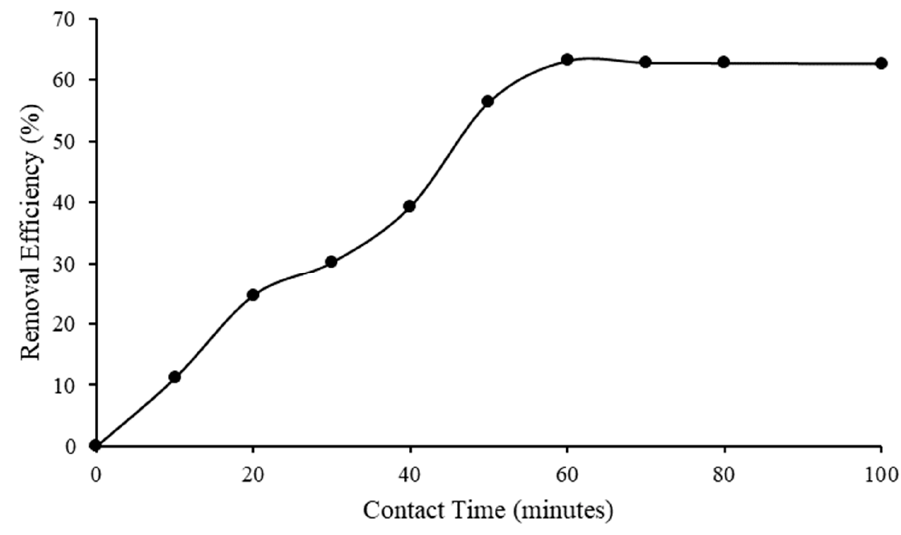
Figure 10. Asphaltene removal efficiency after being treated with [C 16 C 1 Pip] 2 [LS].